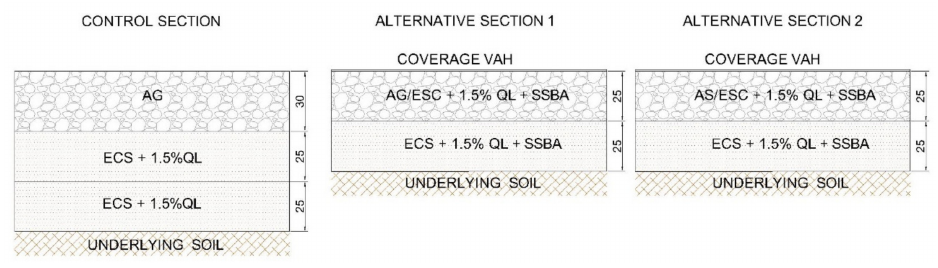
Figure 10. Sections implemented.